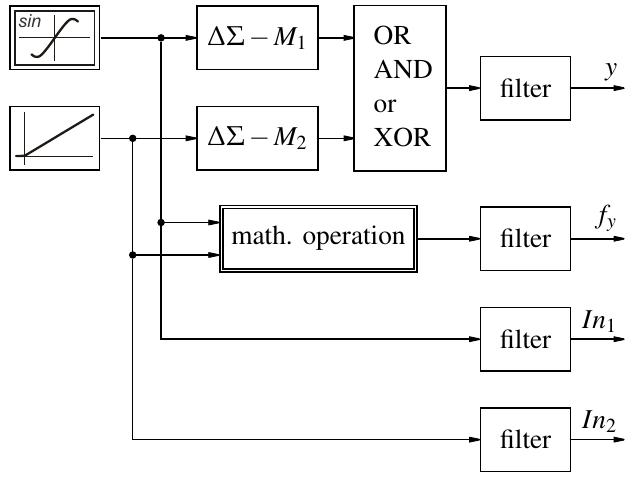
Figure 13. Testbench for evaluating the logic